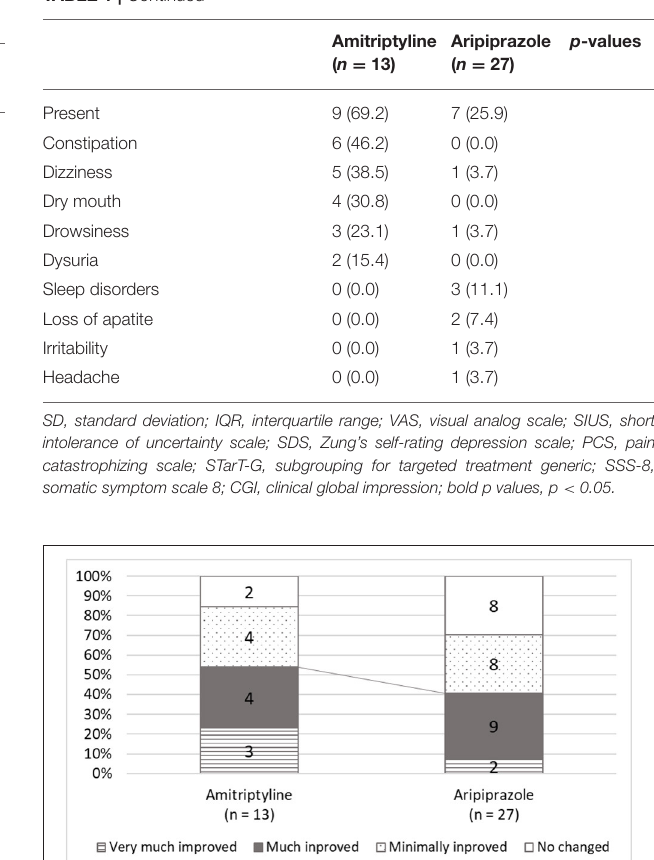
low initial doses and slow titration. Amitriptyline